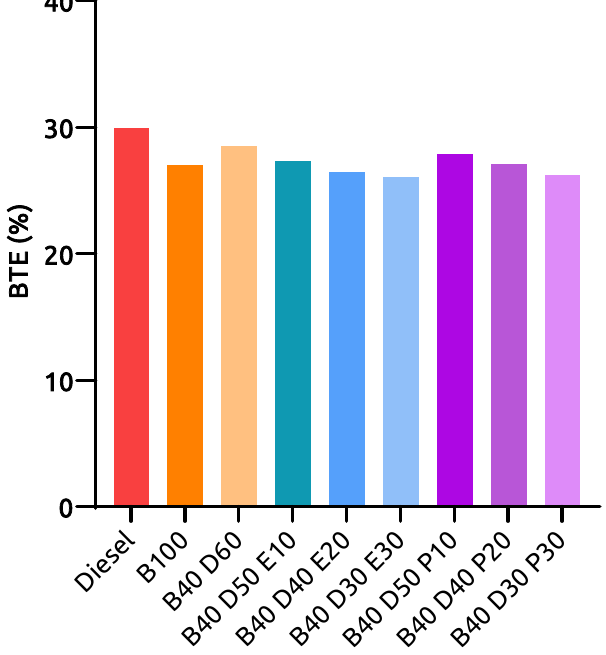
Figure 3. Brake thermal efficiency for tested fuels at full engine load.